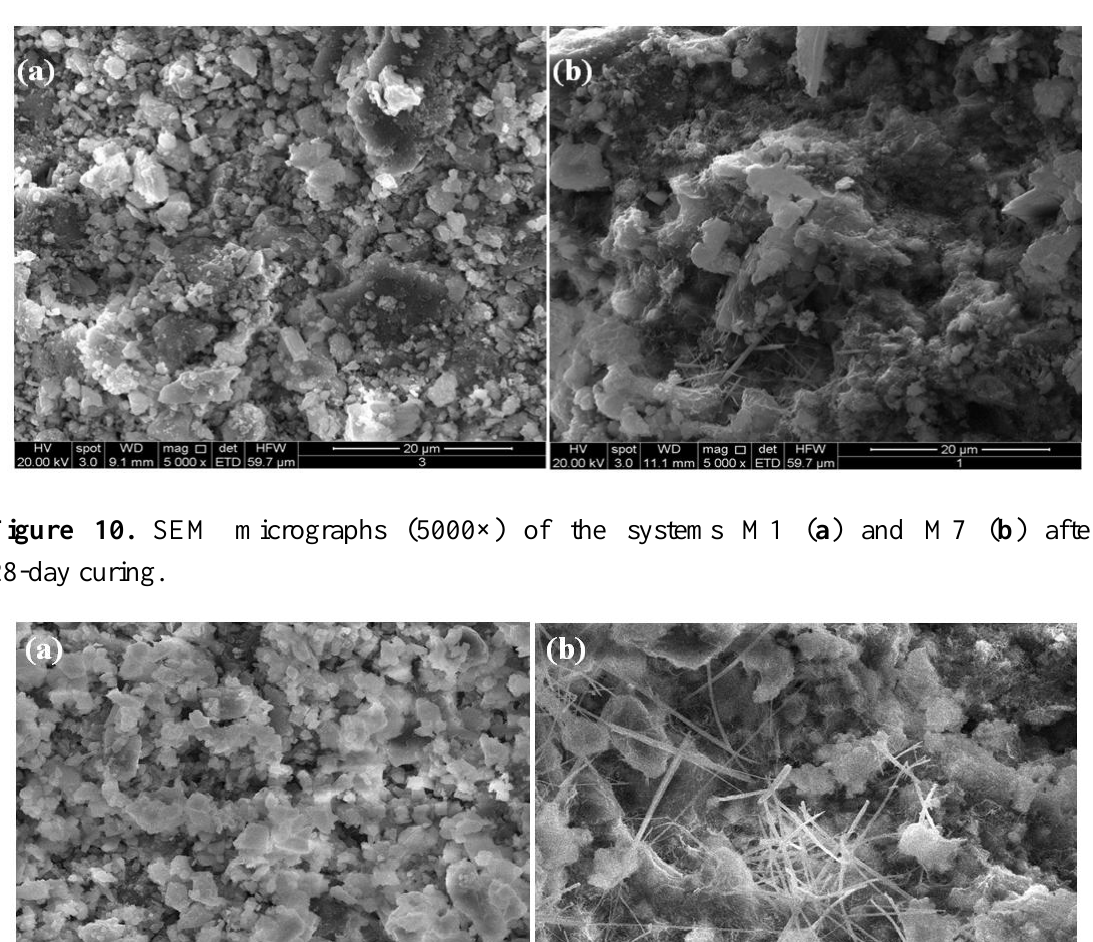
Figure 9. SEM micrographs (5000×) of the systems M1 ( a ) and M7 ( b ) after 14-day curing.